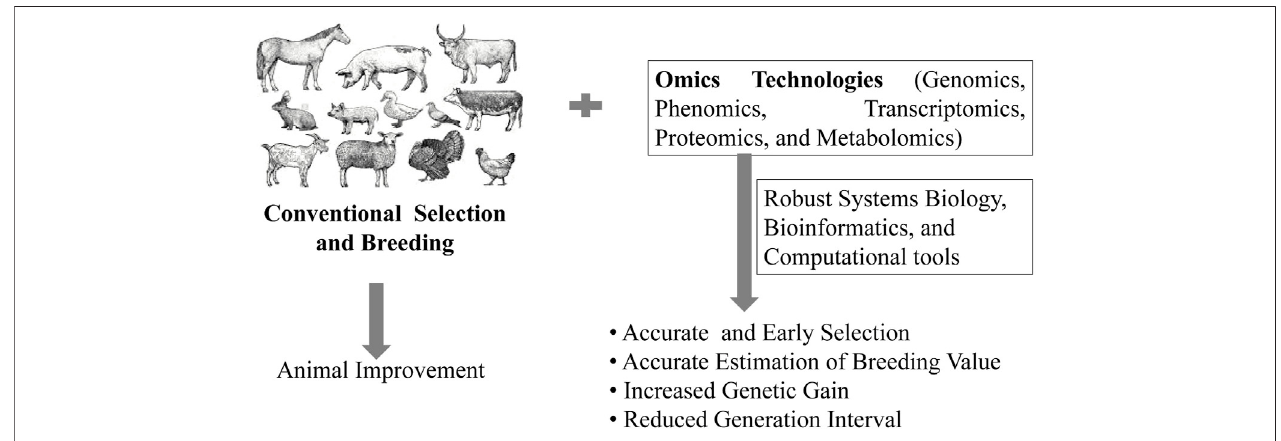
FIGURE 1 | Impact of omics technology in animal